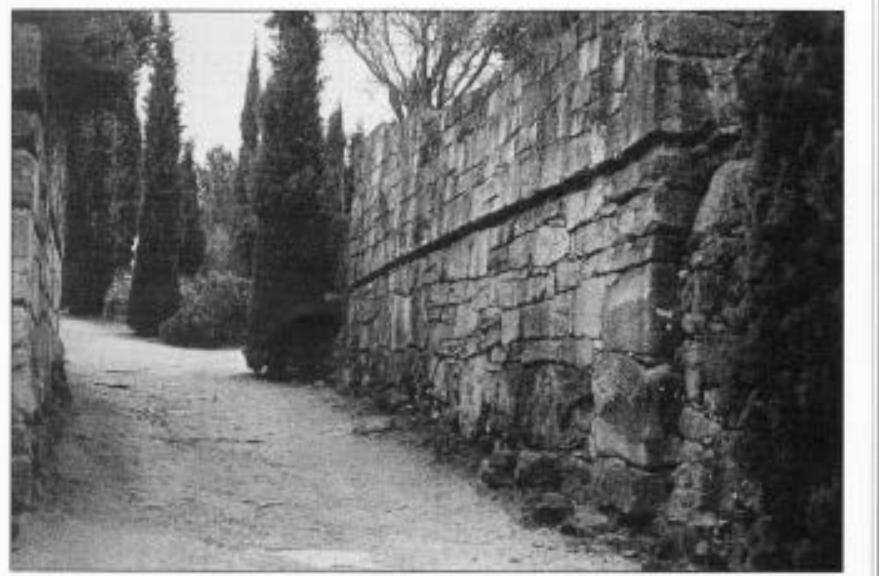
Figure 2 Remains of fortified walls and gate at the native Iberian oppidum of Ullastret, 600-200 be (present-day Puig deS. Andreu, see Fig.